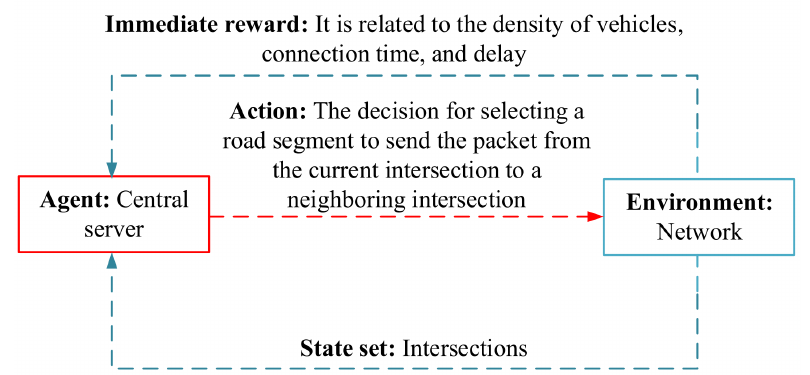
Figure 24. Learning structure in